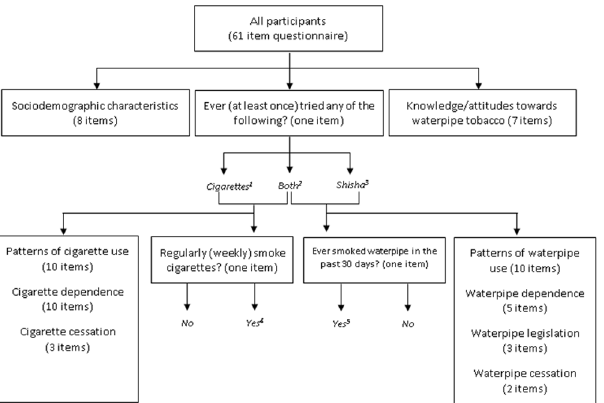
Fig 1. Questionnaire structure and outcome measures. Legend: Outcome measures: 1+2: Ever cigarette use; 2+3: Ever waterpipe use; 2: Ever dual use; 4: Current cigarette use; 5: Current waterpipe use; 4+5: Dual current